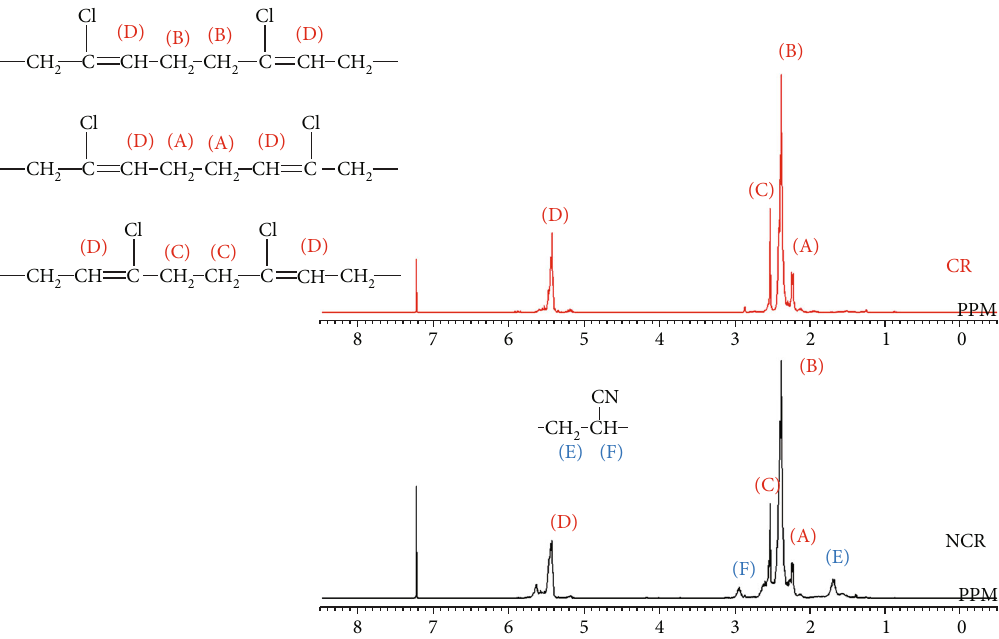
Figure 2: 1 H-NMR spectra of acrylonitrile-chloroprene rubber (NCR) and chloroprene rubber (CR).